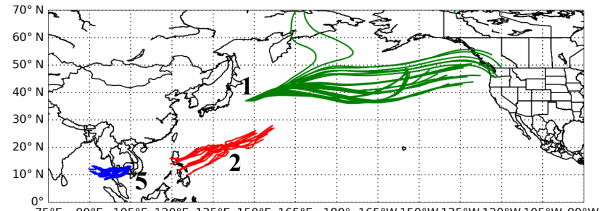
Figure 5. NOAA HYSPLIT model forward trajectory results for the 4-day time period beginning 18 March 2014 at 05:00UTC. We initialize the model from locations 1, 2, and 5 along the CALIPSO transects in Fig. 5. CALIOP aerosol height information at these lo- cations is also used to initialize the model.